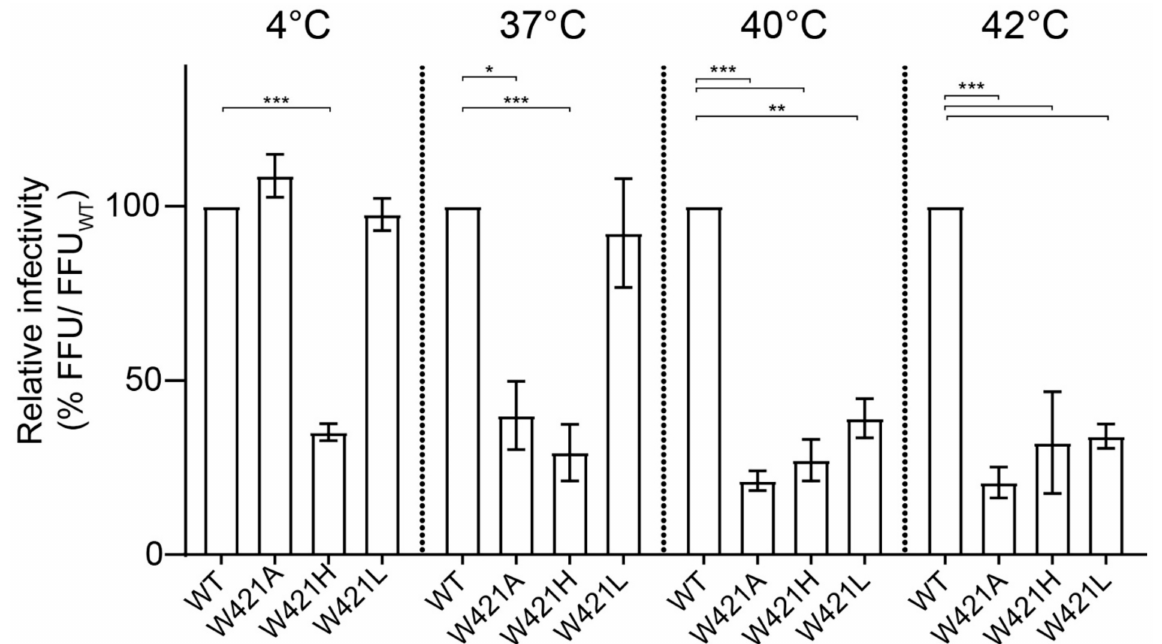
Figure 8. Thermal stability of WT and mutants. Relative infectivity is expressed as percent of focus forming units (FFU) of the WT and mutants at 37 ◦ C, 40 ◦ C and 42 ◦ C relative to the FFU of the WT control at 4 ◦ C. Data are from at least three independent experiments; error bars represent the standard errors of the means (SEM). Asterisks indicate significant differences relative to the WT at the corresponding temperature (ANOVA and Dunnett’s multiple comparison test; * p < 0.05, ** p < 0.01, *** p <